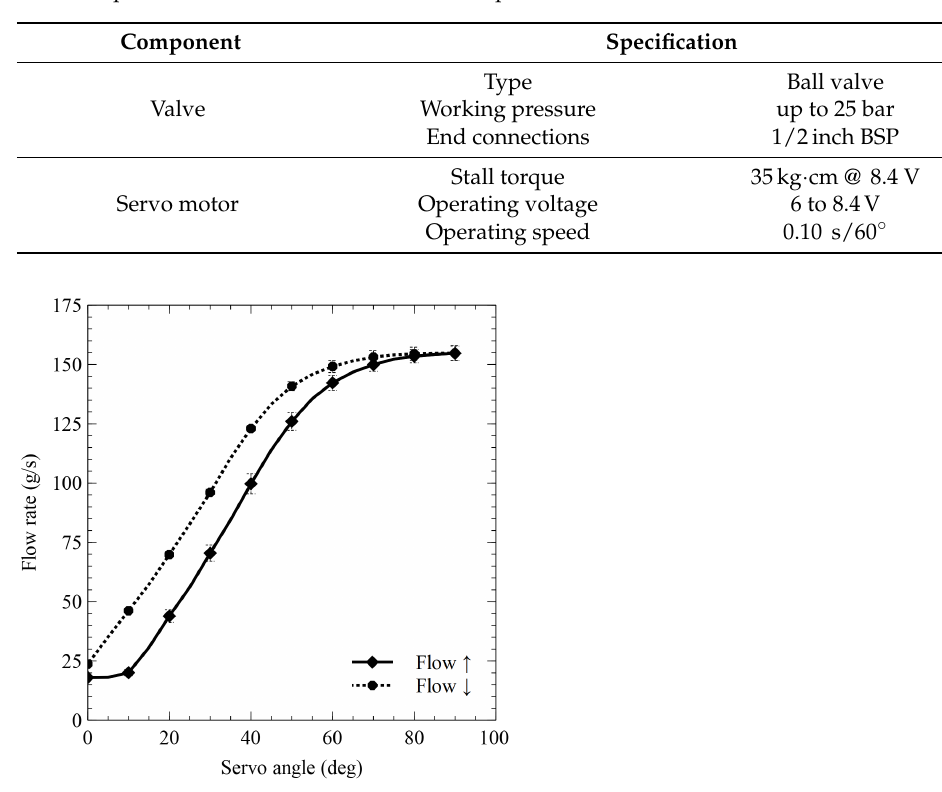
Figure 4. Air flow rate versus servo